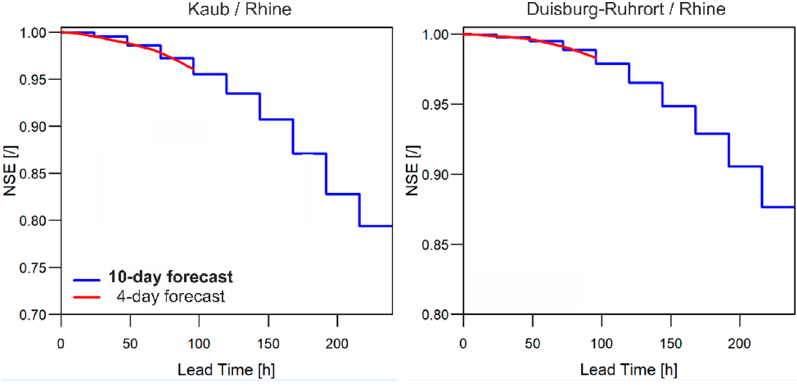
Figure 6. Verification of the 10-day forecast for 2 gauges at the River Rhine using the NSE (period: